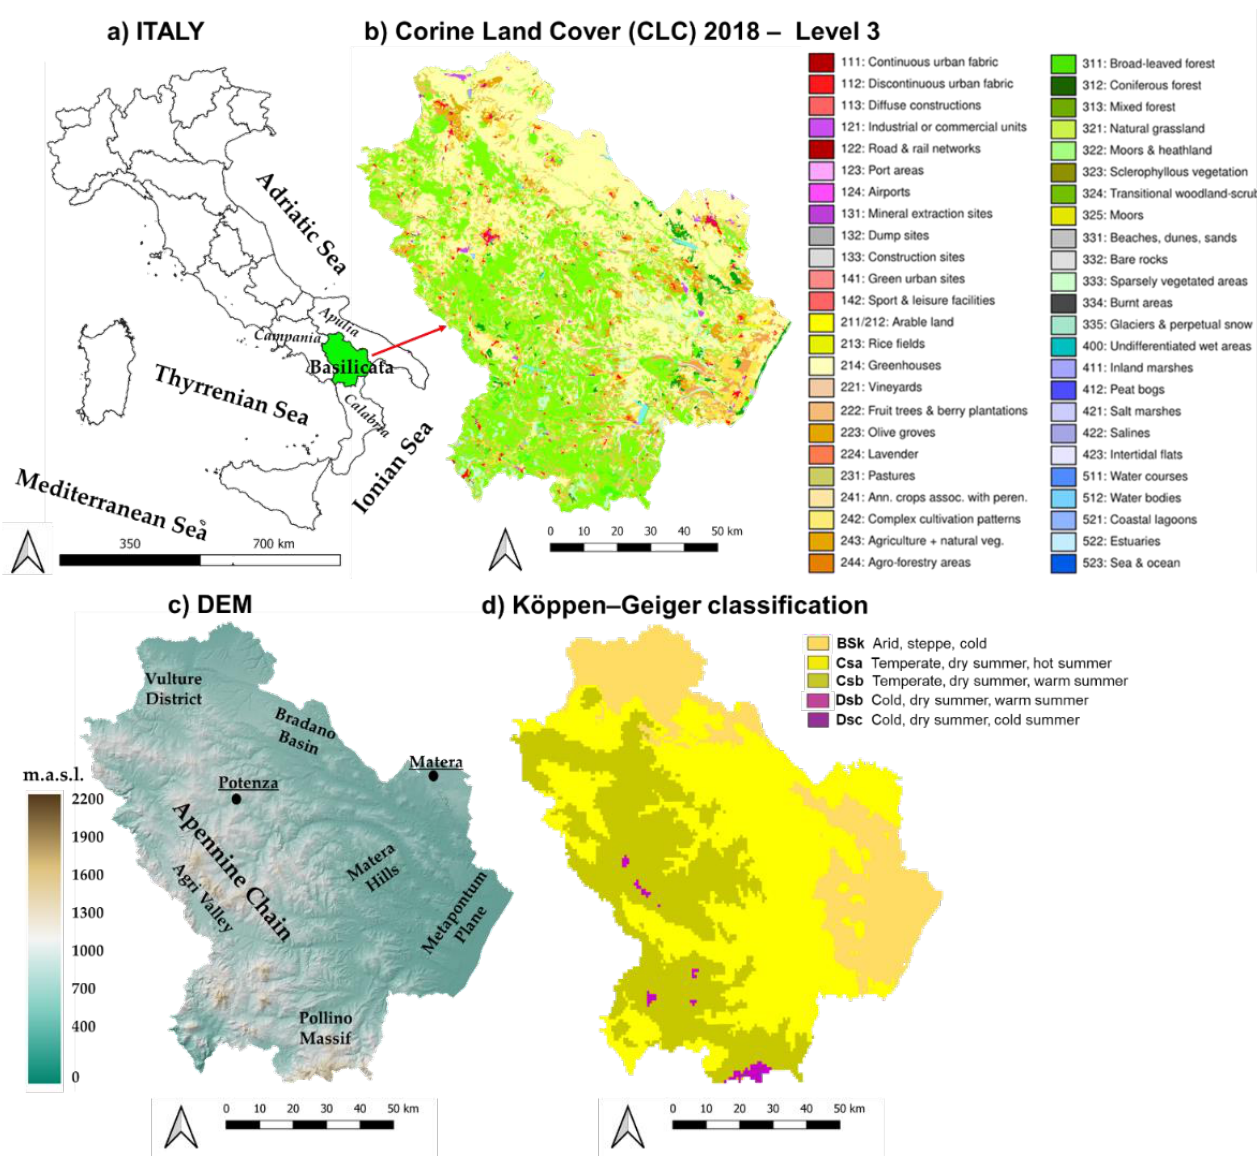
Figure 1. ( a ) Italy subdivided in 20 administrative units (regions); ( b ) Corine Land Cover map 2018 (CLC2018, [82]) at the third level of detail. This map is representative of the entire period investi- gated because changes are scattered and local, not considered relevant for regional assessments; ( c